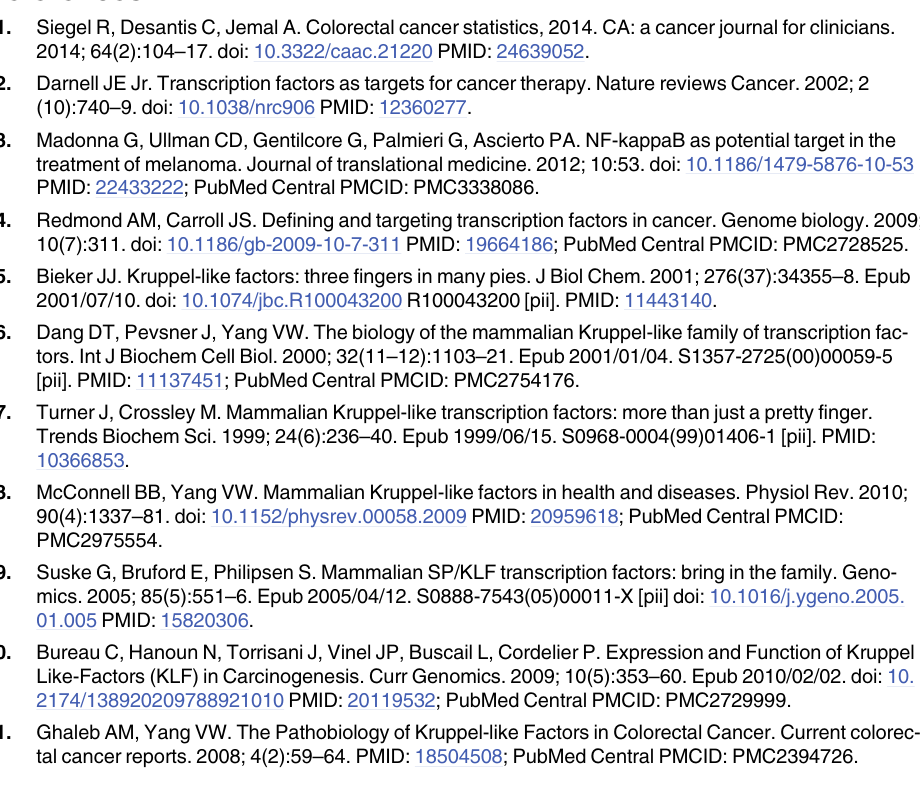
S1 Table. Overexpression of KLF12 alters multiple gene expression. Differences in gene expression between GFP (Control) and KLF12 overexpression (KLF12) were considered statis- tically significant if P <